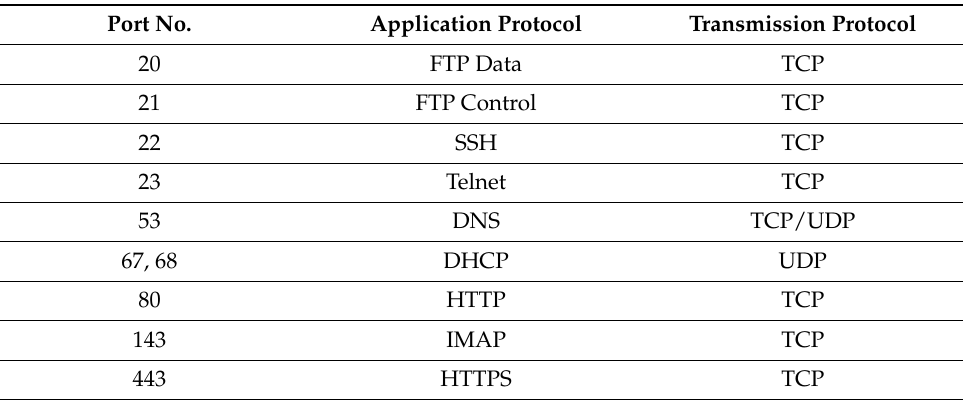
Table 4. Common services. Port